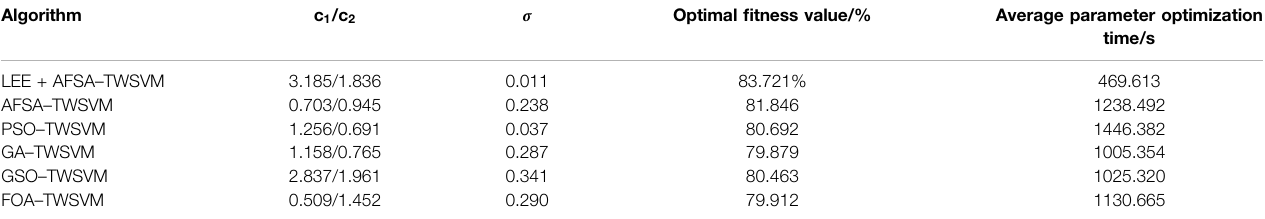
TABLE 1 | Comparison of optimization results of different algorithms. Algorithm